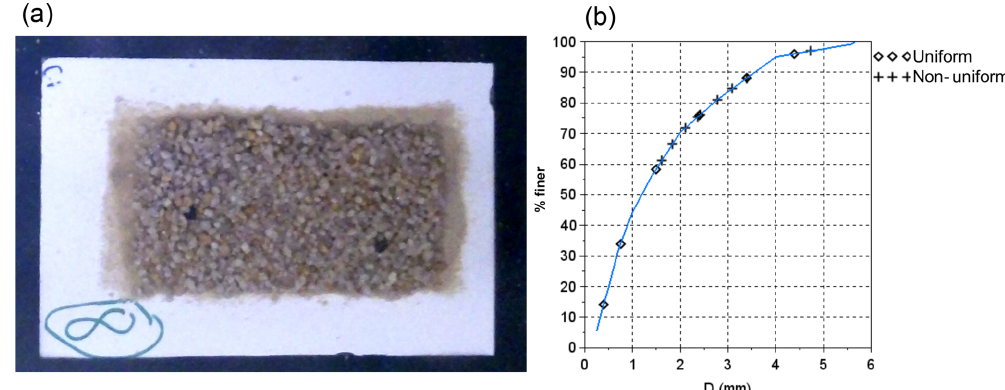
Figure 8. (a) An example of a calibration sample used during the calibration of the bed surface texture, and (b) the median grain size of the calibration data samples, including uniform and non-uniform samples. The line is the flume grain size distribution.